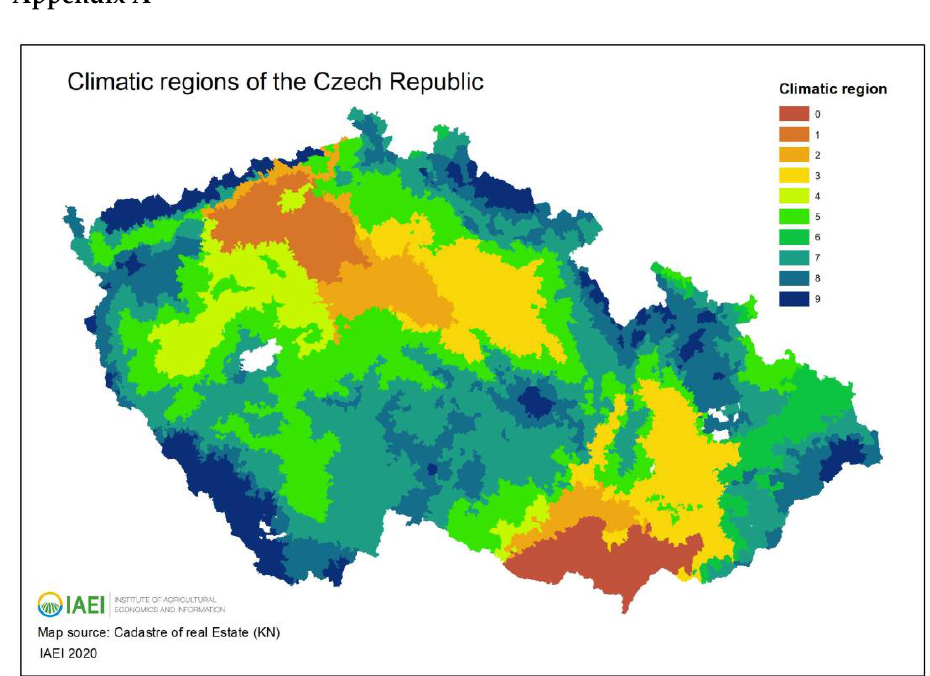
Figure A1. The map of climatic regions of the Czech Republic.